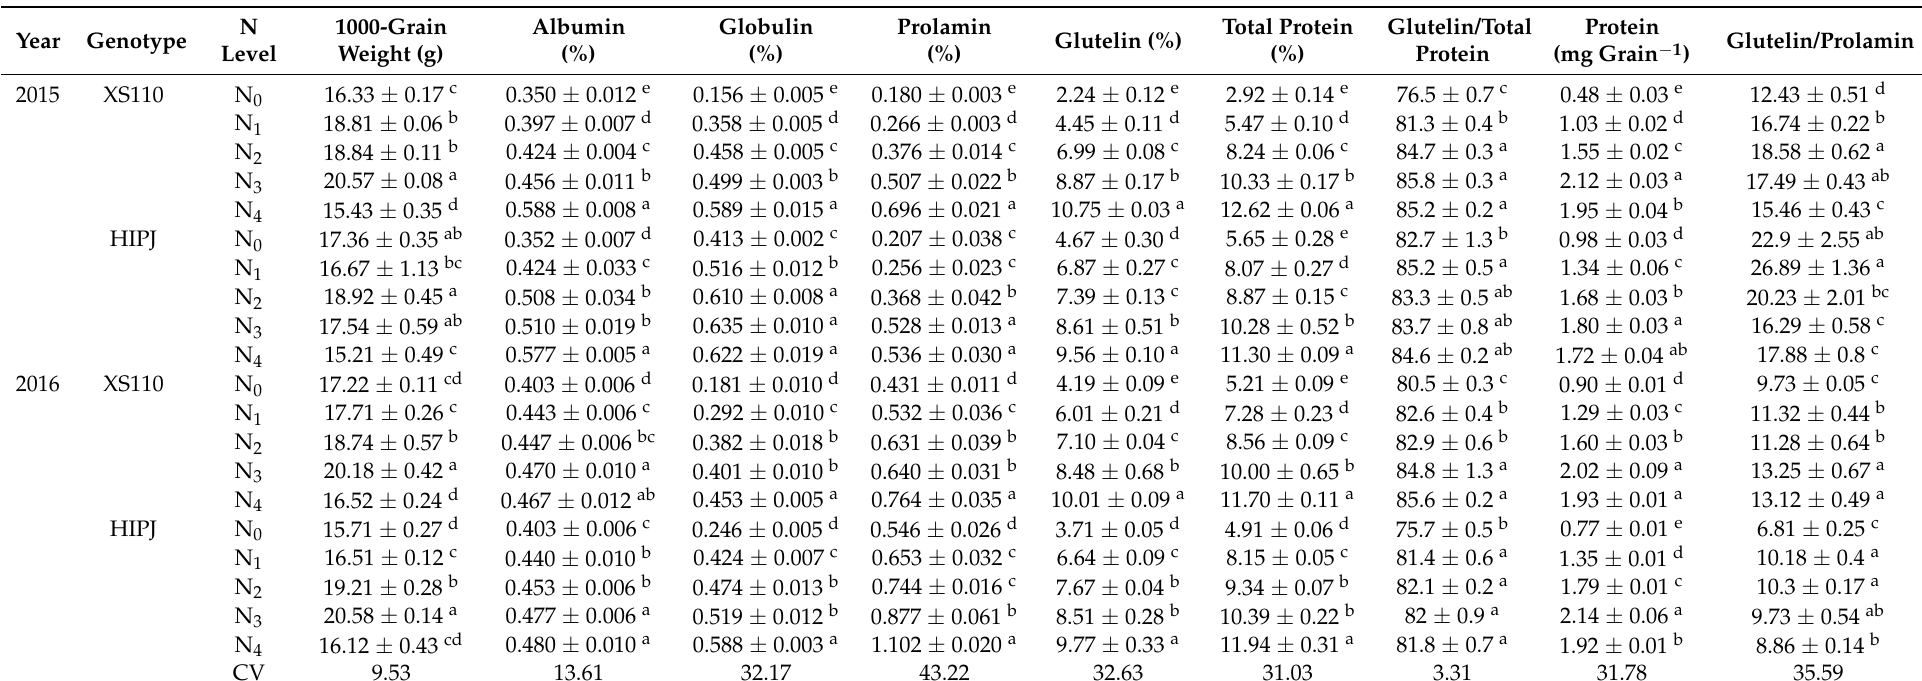
Table 3. Effect of N levels on grain dry weight, albumin, globulin, prolamin, glutelin, total protein concentration, glutelin/total protein, glutelin/prolamin and protein content in rice (detached panicle culture